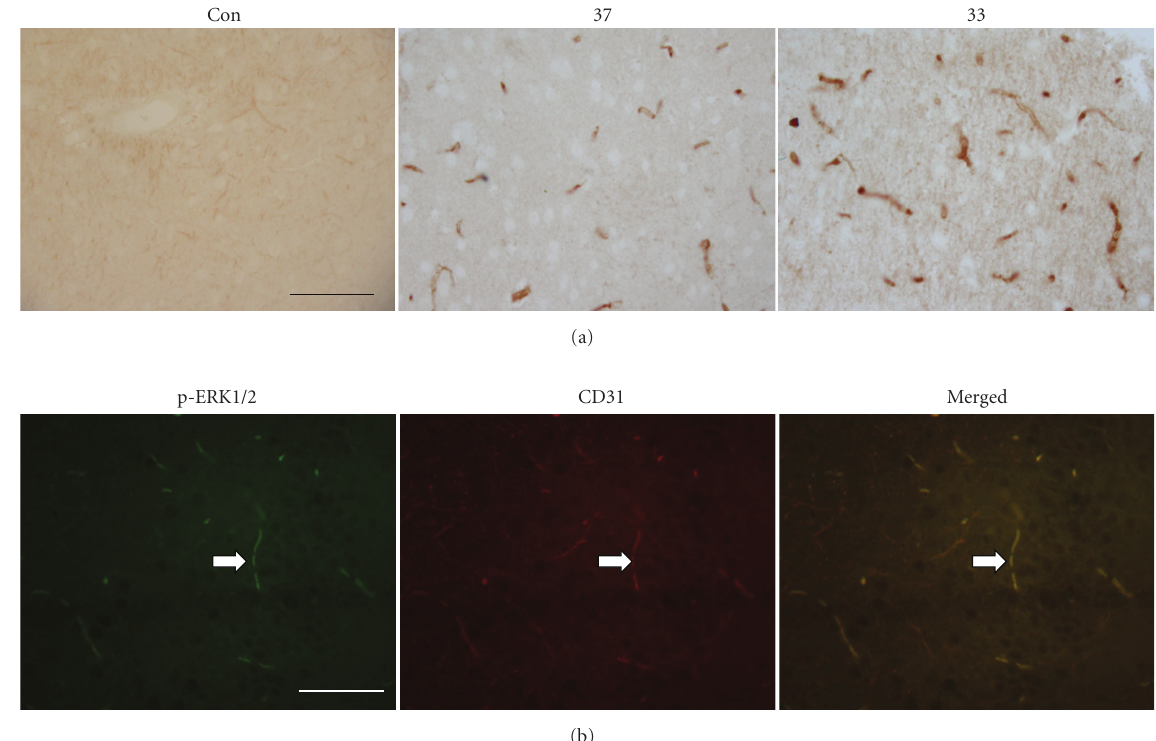
Figure 1: Photomicrographs of the cerebral cortex in the ischemic brain with immunohistochemical staining for phosphorylated ERK1/2. (a) Phosphorylated ERK1/2 is detected in the ischemic brain under normothermic (37) or hypothermic (33) condition but not in the nonischemic control brain (sham) at 2 hours after MCAO initiation. The number and intensity of ERK1/2 immunoreactive vessels were higher in hypothermic group. (b) Fluorescence double labeling illustrates the colocalization of CD31 (red), an endothelial marker, and phosphorylated ERK1/2 (green) in the vessels of the hypothermia group at 2 hours after MCAO initiation. Scale bar: 100 μ